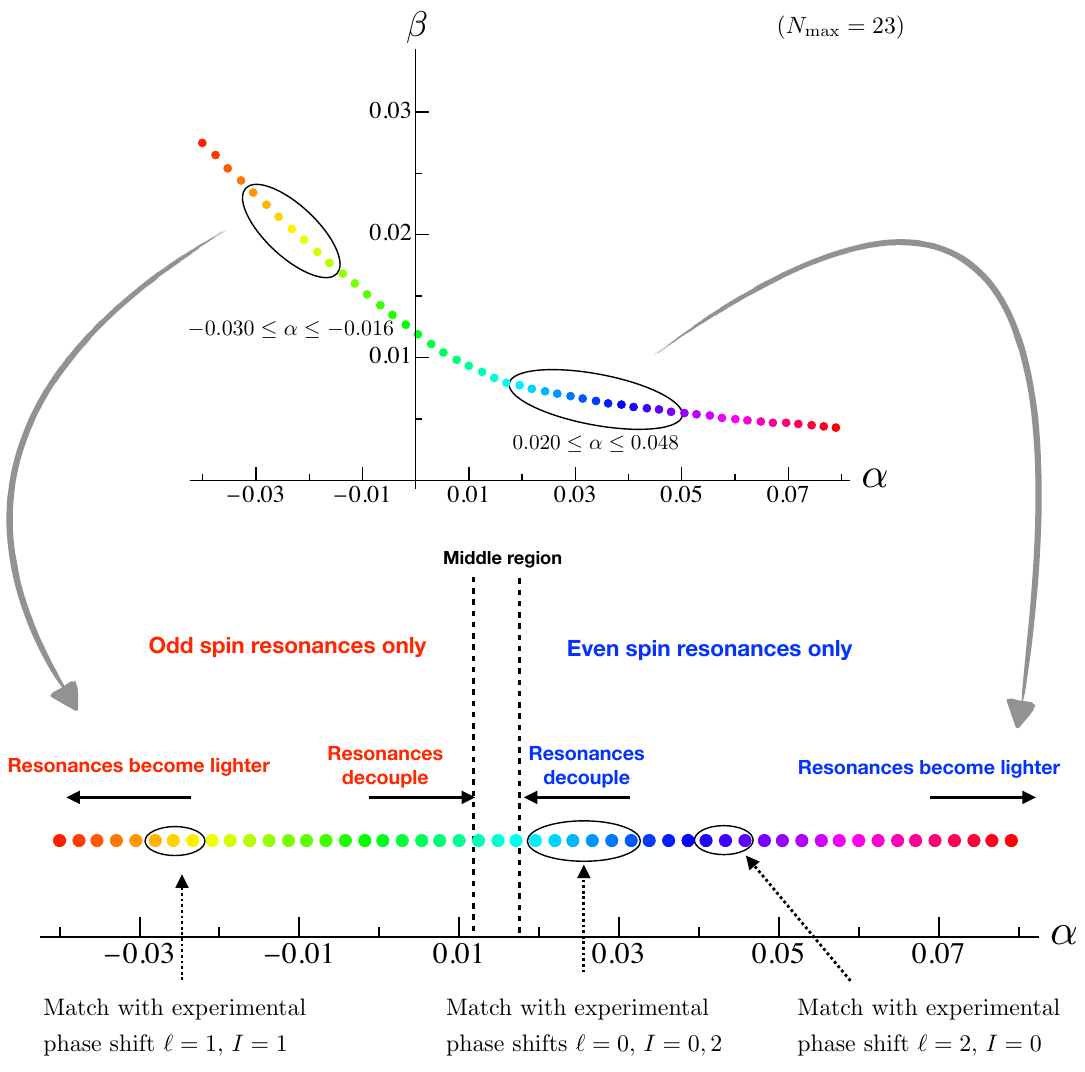
Figure 5 . There is a rich pattern of resonances in the optimal S-matrices as we move along the allowed S-matrix space. On the left, we have odd spin resonances turned on and no even spin resonances. On the right we have the opposite. The real world has both types of resonances so should somehow not be at the boundary. Would be very interesting to force the presence of the ρ resonance as in [25] and repeat this analysis as done in that paper for massive